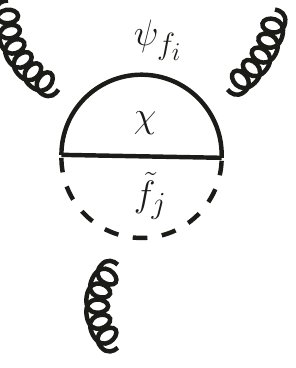
and g predicted in Model I-A, which have already M E